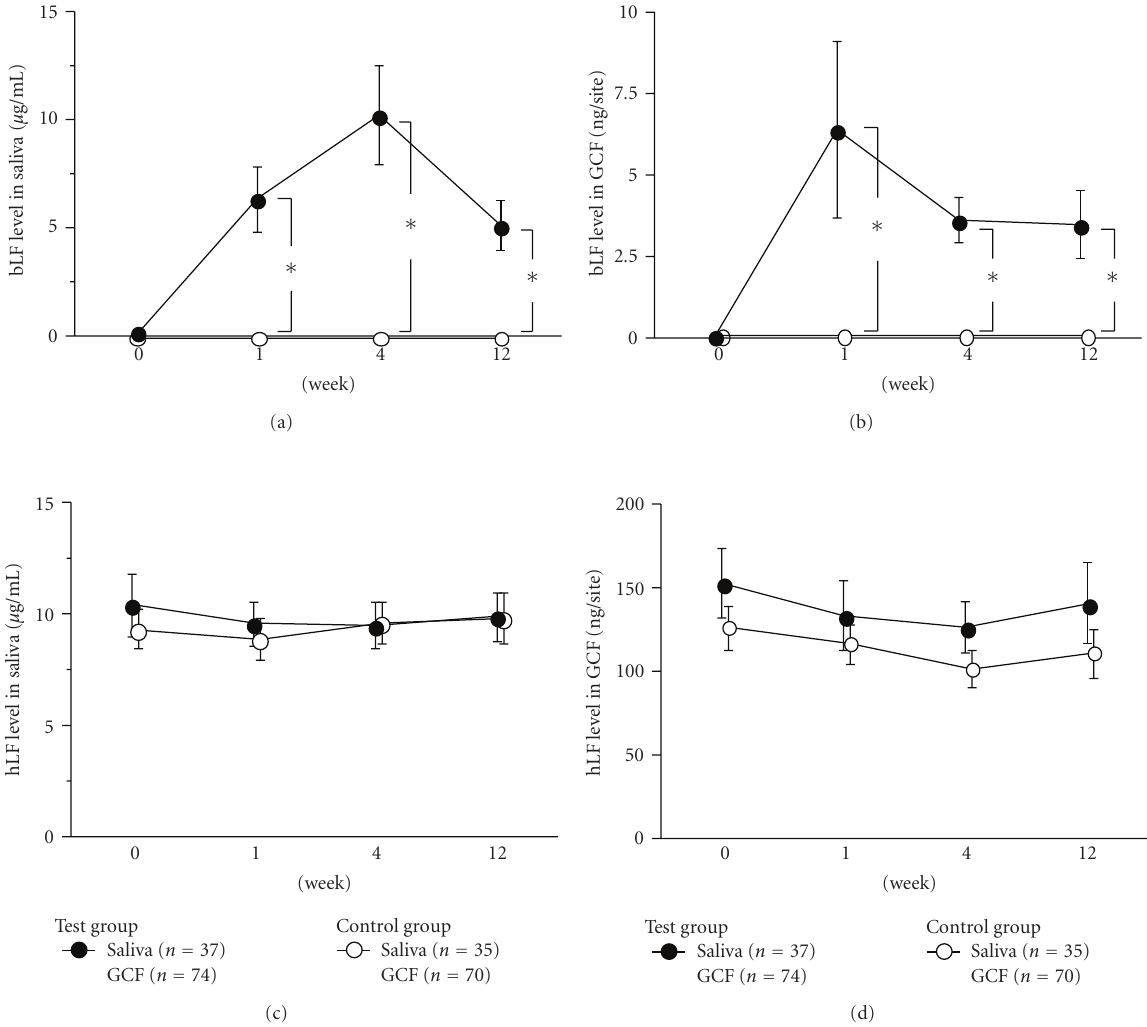
Figure 2: E ff ect of the test tablet on bovine and human LF levels in saliva and gingival crevicular fluid (GCF). Saliva levels of bovine LF (a), GCF levels of bovine LF (b), Saliva levels of human LF (c), and GCF levels of human LF (d) were measured at baseline, 1W, 4W, 12 W. Values represent the mean ± standard error. GCF levels of bovine and human LF were assessed in two teeth with chronic periodontitis per subject. ∗ Significant di ff erence between the test and control groups, as identified by Student’s t -test ( P < .